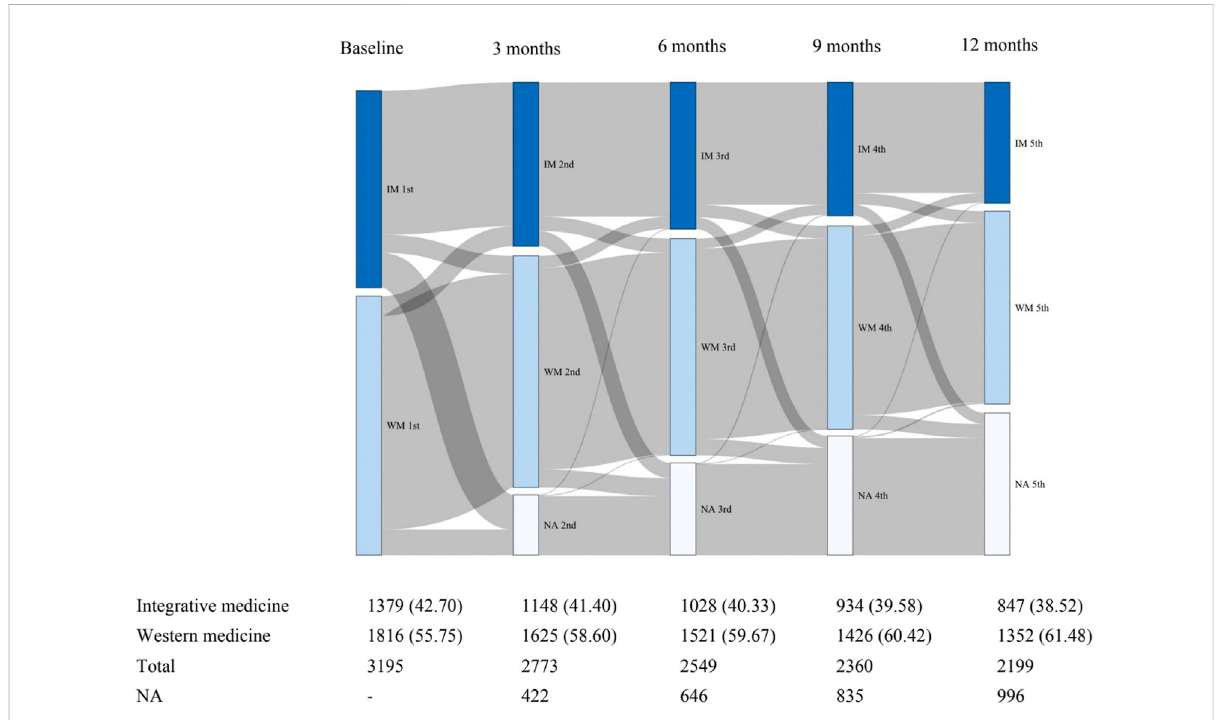
FIGURE 1 Sankey diagram of changes in clinical medicine during the fi rst year of follow-up. IM: Integrative medicine, WM: Western